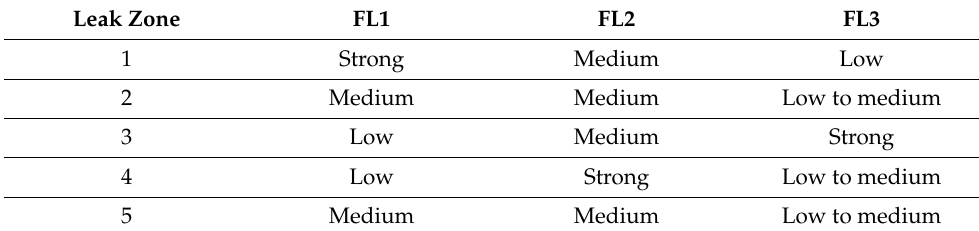
Figure 3. Impact of the leak localization on the water supply flow rate. Table 5. Impact of the leak position on the water supply rate.